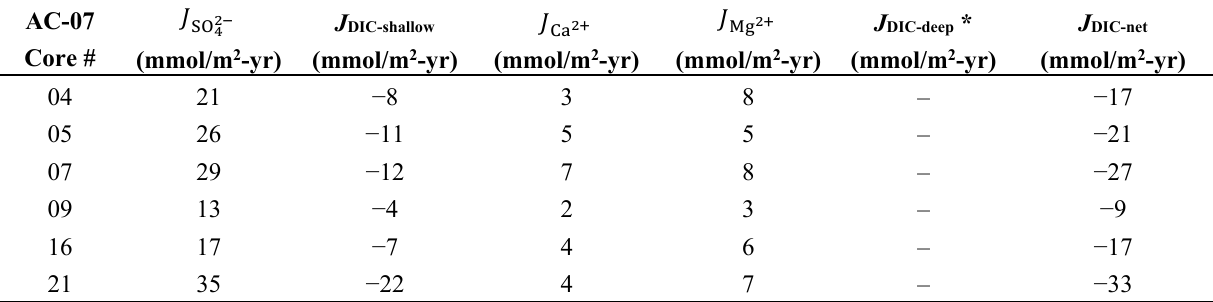
, (cid:1836) , and J DIC-net for the AC-07 piston cores (cid:2887)(cid:2911) (cid:3118)(cid:3126) (cid:2897)(cid:2917) (cid:3118)(cid:3126)